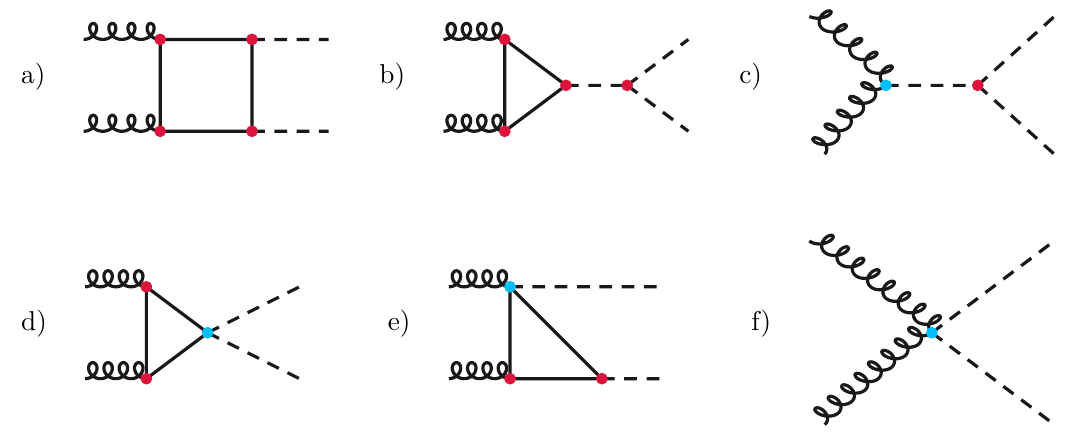
Figure 5 . Feynman diagrams relevant for Di-Higgs production at the LHC. A red vertex indicates interactions present in the SM but modified by the SMEFT operators. A blue vertex indicates interactions not present in the